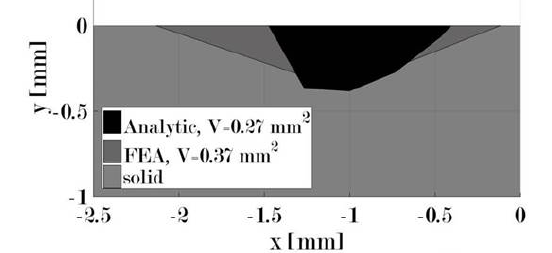
Figure 5. Melt pool geometry.